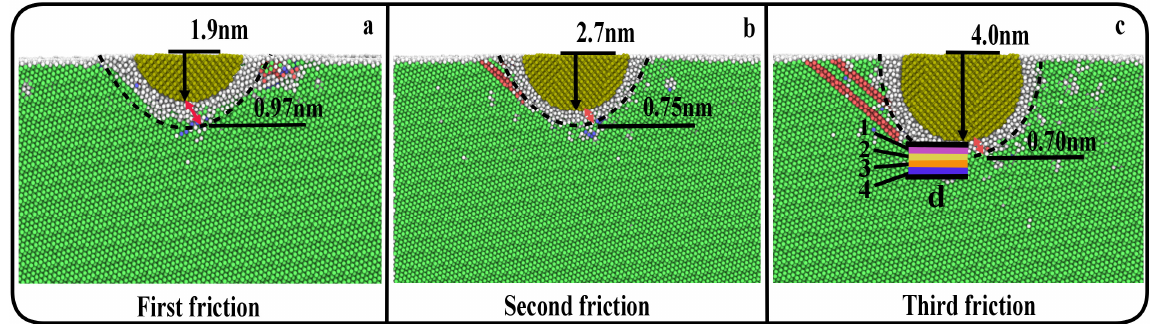
Figure 11. Defects at the bottom of the grinding ball, and ( a – c ) are the cross-sectional views of the grinding ball after three times of friction.